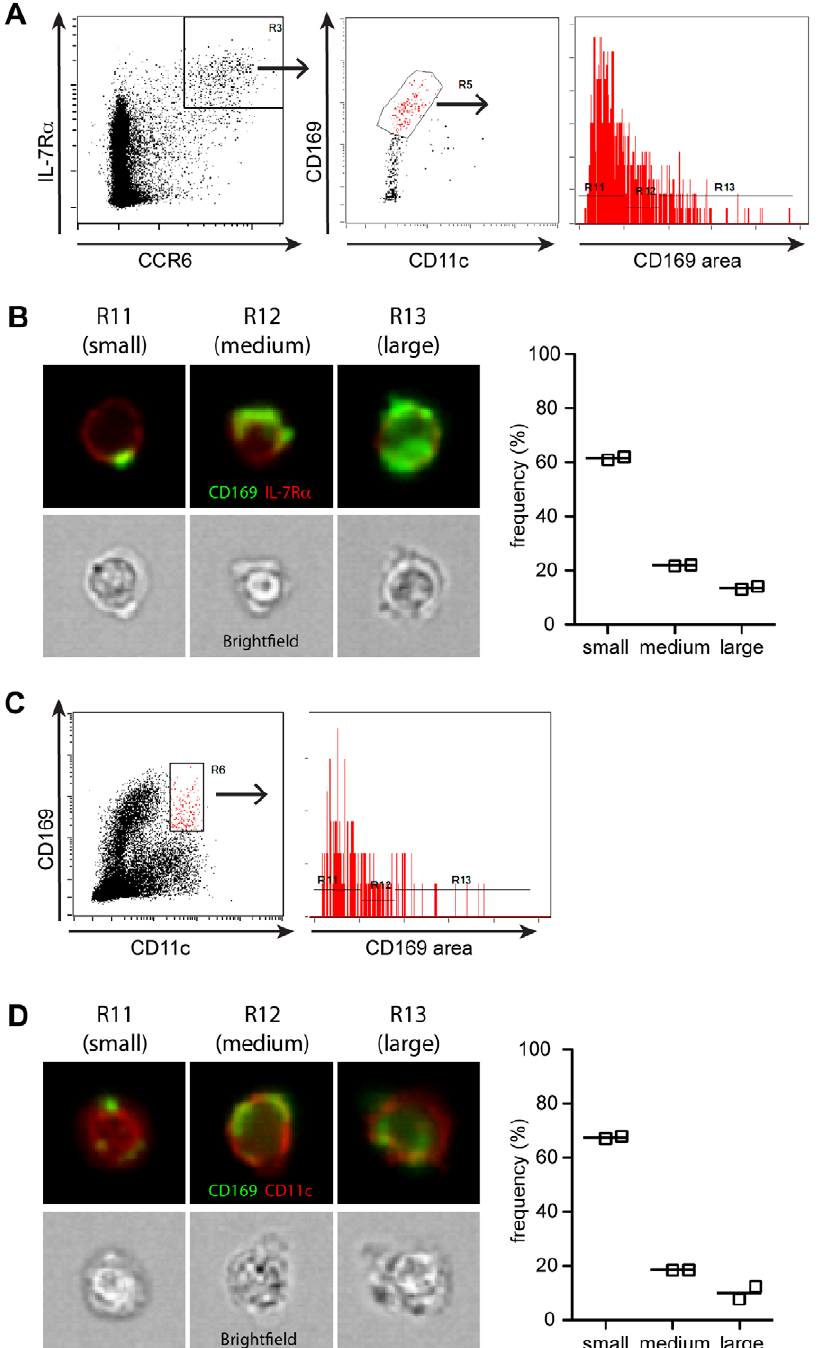
Figure 3. Analysis of CD169 distribution on IL-7R a hi CCR6 + lymphocytes and CD11c hi dendritic cells using ImageStreamX imaging flow cytometry. (A) Gating scheme to identify CD169 + IL-7R a hi CCR6 + cells analyzed on an ImageStreamX imaging flow cytometer (Amnis Corp). The area of CD169 staining on images of the gated cells was quantified using a Threshold mask on the upper 60% of the pixel intensities (right panel). (B) Representative images of cells with small, medium, and large areas of CD169 area based on the histogram in (A). Channels for CD169 (green), IL-17R a (red), and brightfield are shown. Graph on right shows the frequency of cells falling in each gate (n=2 mice, lines indicate means). (C) Gating scheme to identify CD169 + CD11c + cells analyzed on an ImageStreamX imaging flow cytometer. The area of CD169 staining on images of the gated cells was quantified as described in (A). (D) Representative images of cells with small, medium, and large areas of CD169 area based on the histogram in (C). Channels for CD169 (green) IL-17R a (red), and brightfield are shown. Graph on right shows the frequency of cells falling in each gate (n=2 mice, lines indicate means). Data are representative of one experiment with two mice. In a second experiment with two mice, CD169 + blebs were visualized on CD169 + CCR6 + TCR cd + cells.